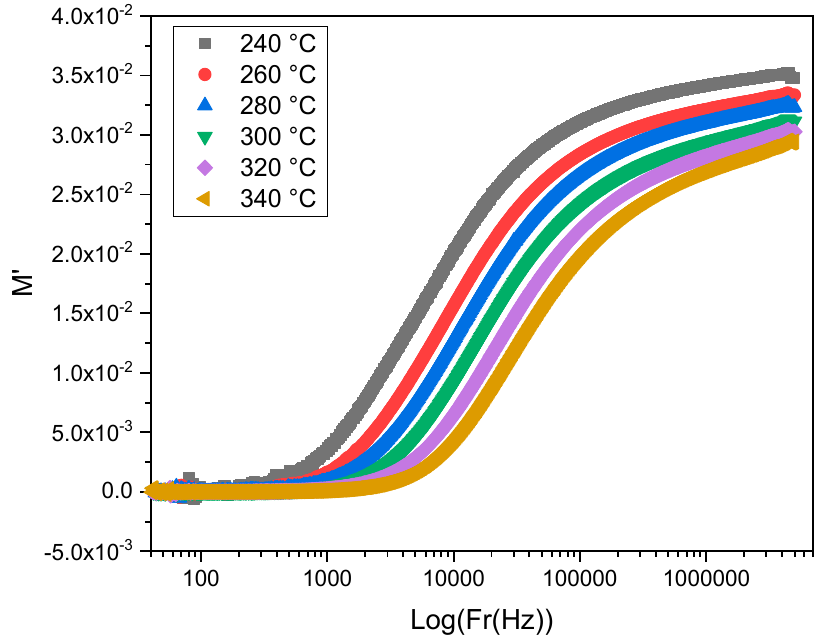
Figure 13. The frequency dependence of M’ for TZV15 at different temperatures. The imaginary part M” represents a maximum peak M” max within the frequency (see Figure 14a). In the frequency region below the M” peak, the polarons drift to long distances, whereas, for the frequency range above the peak, the polarons are confined to potential wells where they are free to move. Therefore, the peak frequency represents the transition from long- to short-range mobility [46]. The asymmetric curve of M” and its variation within the frequency at each temperature suggested a spread of the relaxation times, which can be related to a process of coupling of the individual relaxation: one site needs to relax before the other can be done [8]. On the other hand, the shift towards higher frequencies of the relaxation peak with increasing temperature indicates the dependance of the relaxation process on temperature.